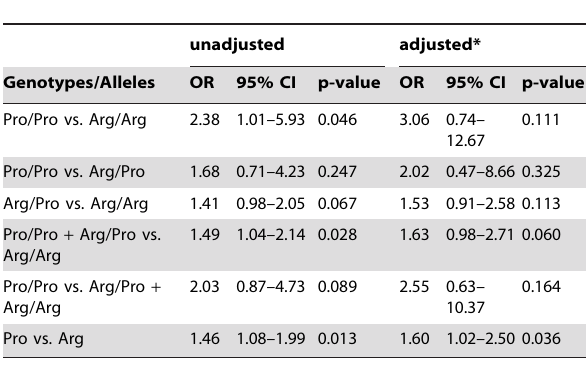
Table 2. Odds ratios and 95% confidence intervals for TP53 Arg72Pro genotypes or alleles and breast cancer